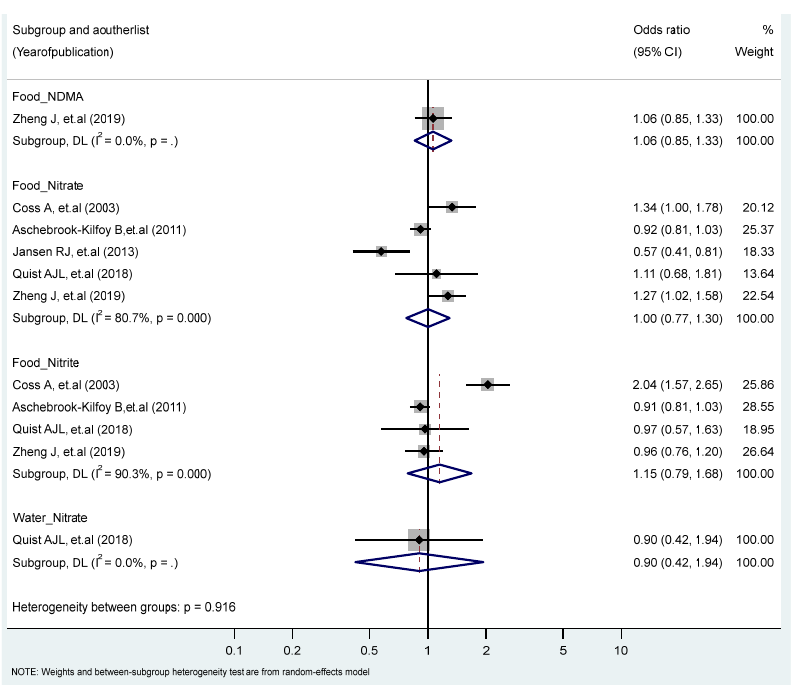
Figure 4. Forest plot (random ‐ effects model) quantifying the relationships between NDMA, nitrite, and nitrate intake and colorectal cancer risk stratified by sources. List of references includes: [32,36,42,43,46,53–56,59,62]. We found no significant associations between PC in the highest vs. the lowest levels of nitrate, nitrite, and NDMA. However, we observed significant heterogeneity for the food intake of nitrate (I 2 = 80.7%, P-heterogeneity = 0.000), and nitrite (I 2 = 93.5%, P- heterogeneity = 0.000) (Figure 5). No significant differences were found by study types, genders, topographies, and food sources (plants, animals) (Tables 1 and 2).